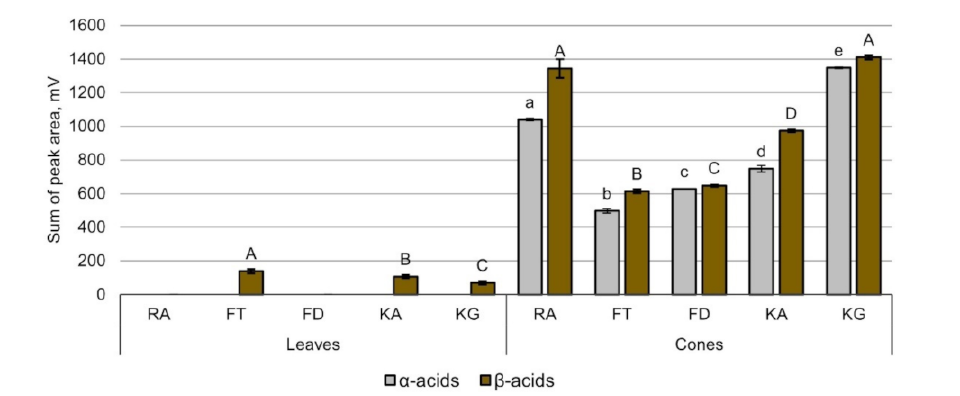
Figure 3. The concentration of α - and β - bitter acids in the samples, expressed as a sum of corre- sponding HPLC/UV peak area (sample codes see in Table 4. Results represent averaged values of three repetitions. a–e—different letters indicate significant differences between β -acids content among varieties ( p ≤ 0.05); A–D—different capital letters indicate significant differences between α -acids content among varieties ( p ≤